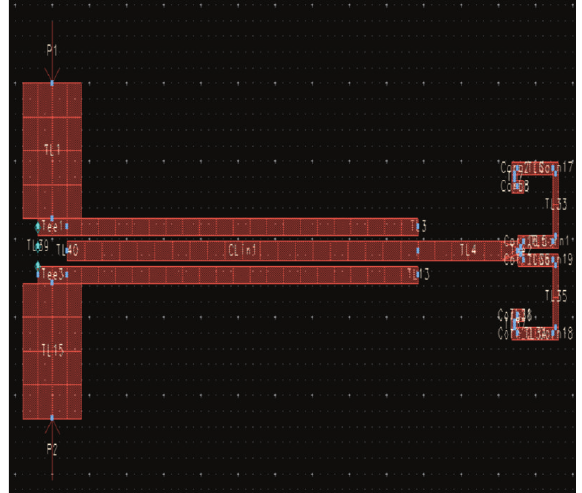
Figure 24: Structure of the proposed new broadband band-pass